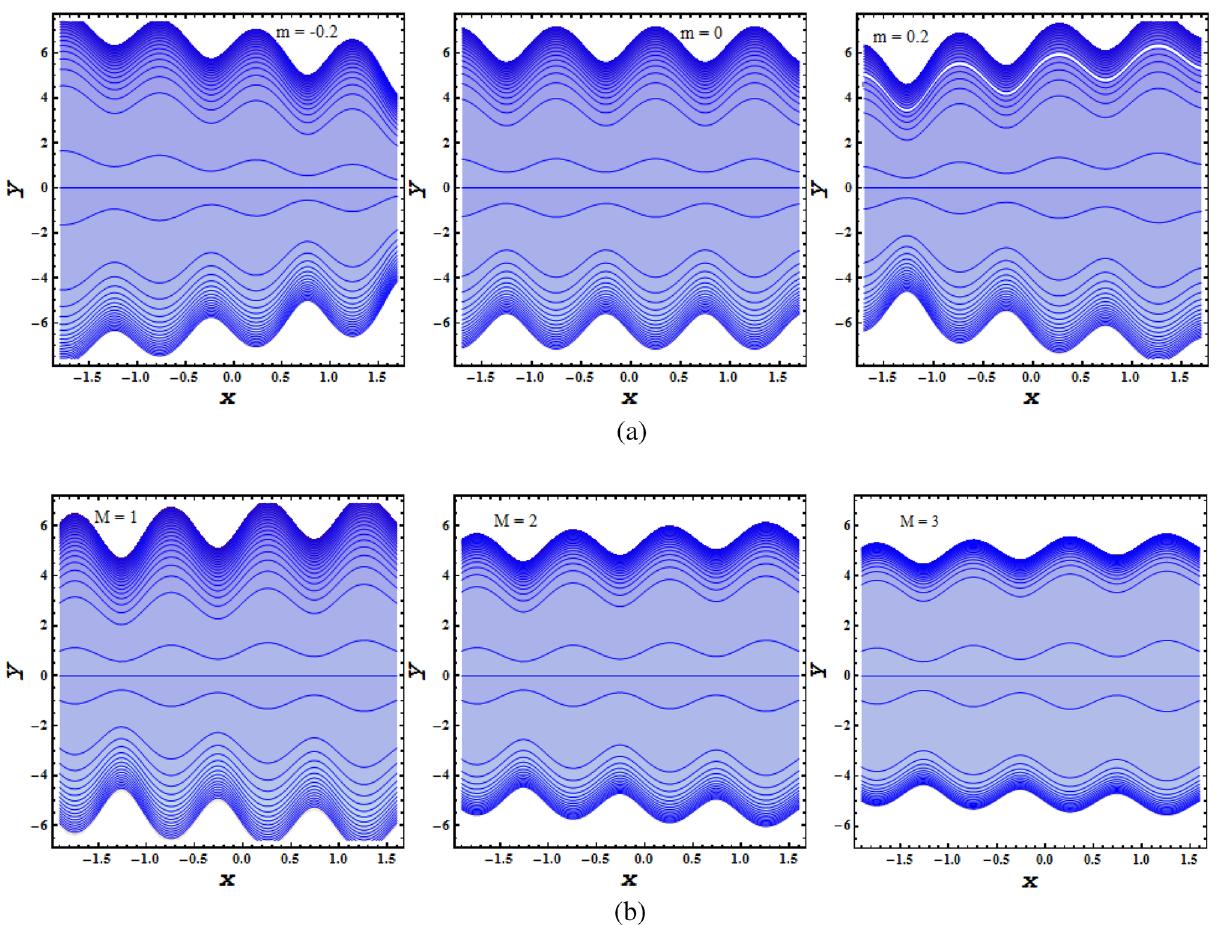
Figure 7. ( a ) Impact of non-unifromity parameter m on the Stream function ψ . ( b ) Impact of Hartmann number M on the Stream function ψ